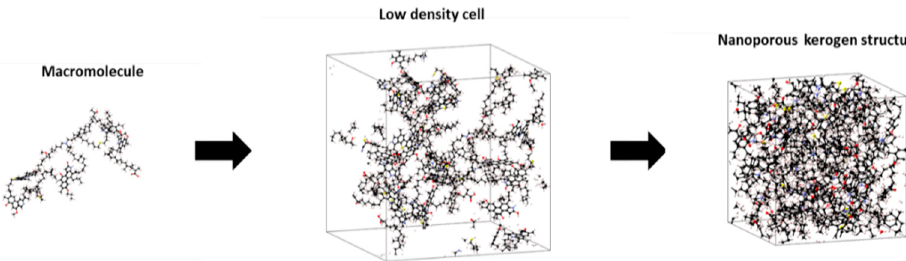
Figure 3. Creation of a nanoporous type II-A kerogen structure from a single macromolecule. The same steps were followed to create the nanoporous structures of the other kerogens.